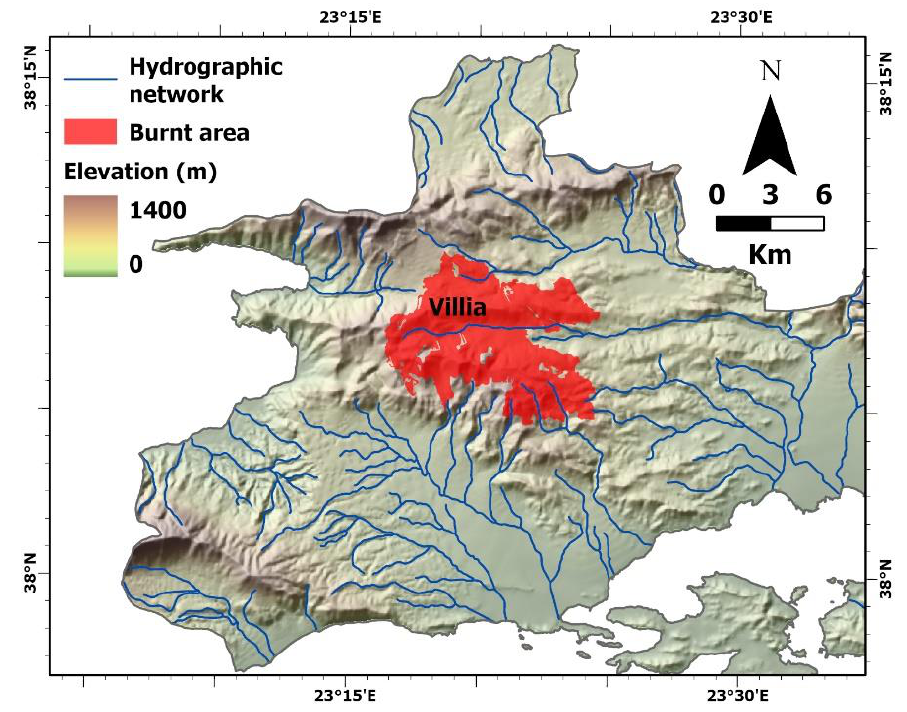
Figure 3. The map depicts the total burnt area of Villia, where a drainage system crosses the affected area in an East – West direction.